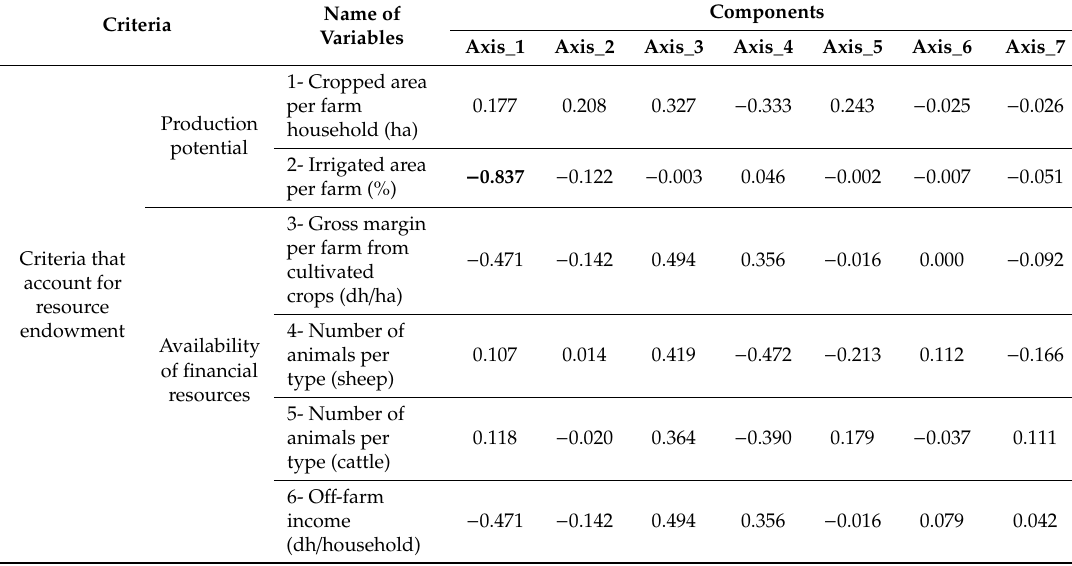
Figure 4. Projection of variables on the first two principle components. 1. % of production per type of vegetable products. 2. Irrigated area per farm. 3. Total labour per farm. 4. % of calories provided by self-consumption per type of vegetable products. 5. Total quantity of irrigation water per farm. 6. % of production per type of cereal products. 7. Total quantity of N fertilization per farm. 8. Total cost of seeds per crop and farm_Onion. 9. % of calories provided by self-consumption per type of cereal products. 10. Total cost of seeds per crop and farm_Potato. 11. Total cost of seeds per crop and farm_Wheat. 12. % of production per type of legume products. 13. Total cost of seeds per crop and farm_Faba bean. 14. % of calories provided from self-consumption per type of legume products. 15. Number of animals per type (sheep). 16. Number of animals per type (cattle). 17. Gross margin per farm from cultivated crops. 18. Total cost of seeds per crop and farm_Barley. 19. Total cost of seeds per crop and farm_Chickpea 20. Cropped area per farm household. 21. Family working population size. 22. Total mechanization cost per farm. 23. Off-farm income. Table 3: Five components resulting from the principal components analysis with loadings for each of the 23 variables and percentage of the cumulative variance explained